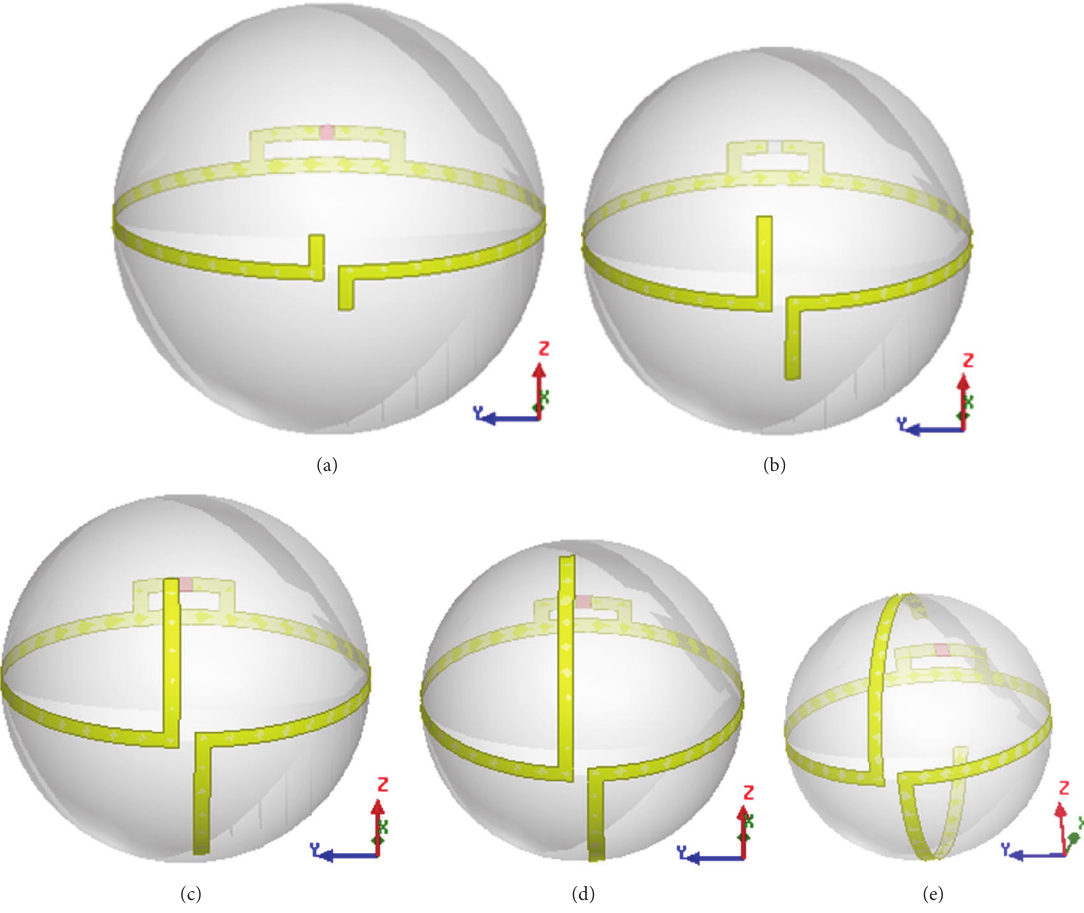
Figure 14: Structure of 3D spherical antennas of different radius: (a) 𝑟 = 22 mm, (b) 𝑟 = 20mm, (c) 𝑟 = 18mm, (d) 𝑟 = 16mm, and (e) 𝑟 =